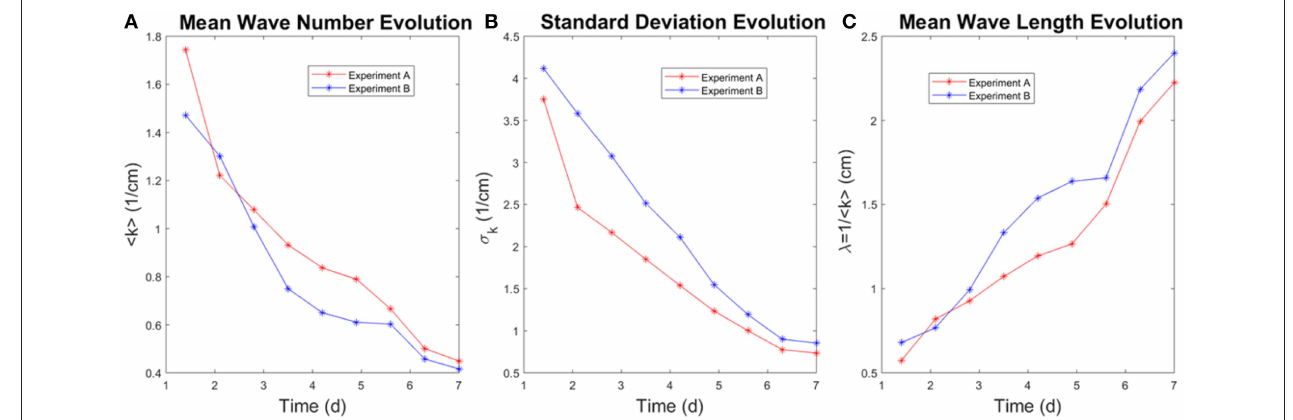
FIGURE 10 | The figure shows the mean wavenumber (for k > 0.1 cm − 1 ), its standard deviation and the mean wavelength ( λ = 1 / k ) evolution with time for two experiments with the same aperture h = 250 µ m and the withdrawing rate Q = 0.18 ml / min . (A) The average wavenumber decreases with time. (B) The standard deviation decreases with time. (C) The average fingering wavelength increases with time.